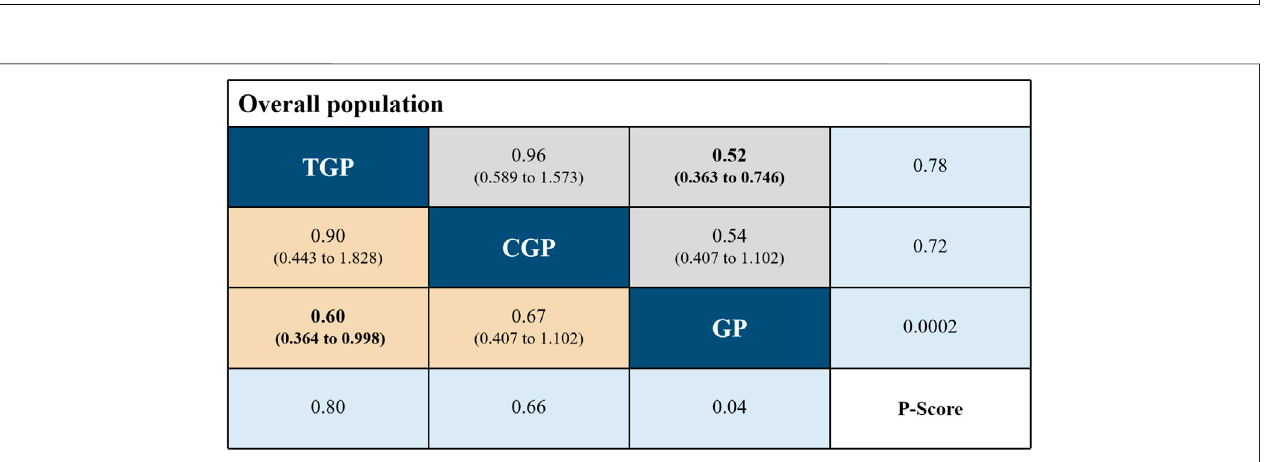
FIGURE 3 | The pooled HR; 95%CI and p -values for OS (lower triangle) and PFS (upper triangle) of the network meta-analysis; signi fi cant results are in bold. Abbreviation: TGP, toripalimab plus gemcitabine and cisplatin; CGP, camrelizumab plus gemcitabine and cisplatin; GP, gemcitabine plus cisplatin; OS, overall survival; PFS, progression-free survival.